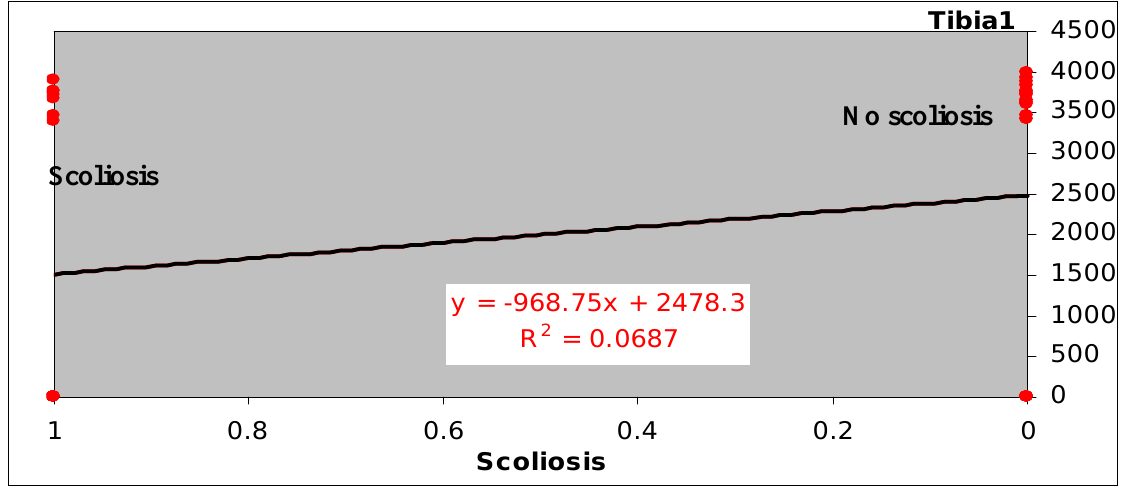
FIGURE 7 . The connection between scoliosis and tibia bone